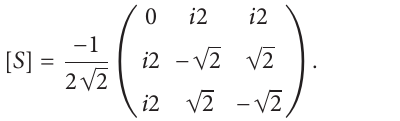
where [𝑉 + ] and [𝑉 − ] are the two vectors containing the values of 𝑉 + 𝑝 and 𝑉 − 𝑝 for 𝑝 varying from 1 to 𝑃